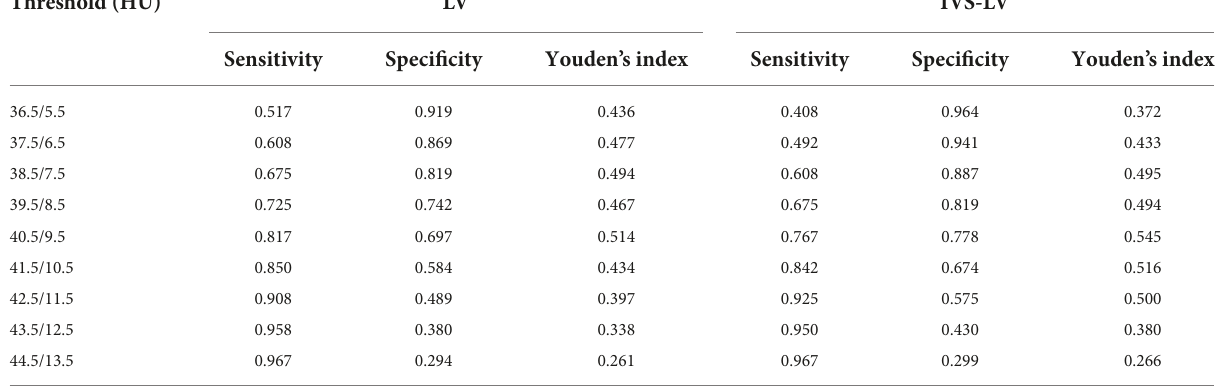
TABLE 10 ROC analysis of LV and IVS-LV in the CDCT